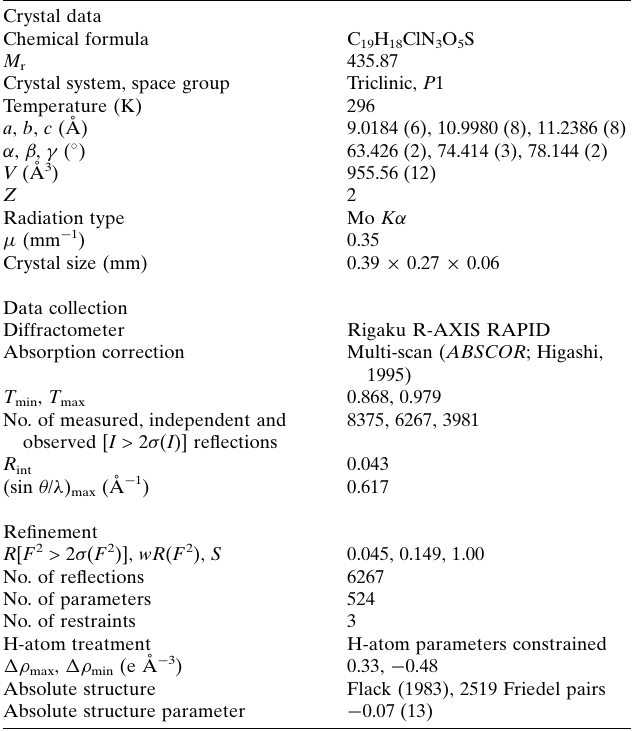
Table 3 Experimental details. Crystal data Chemical